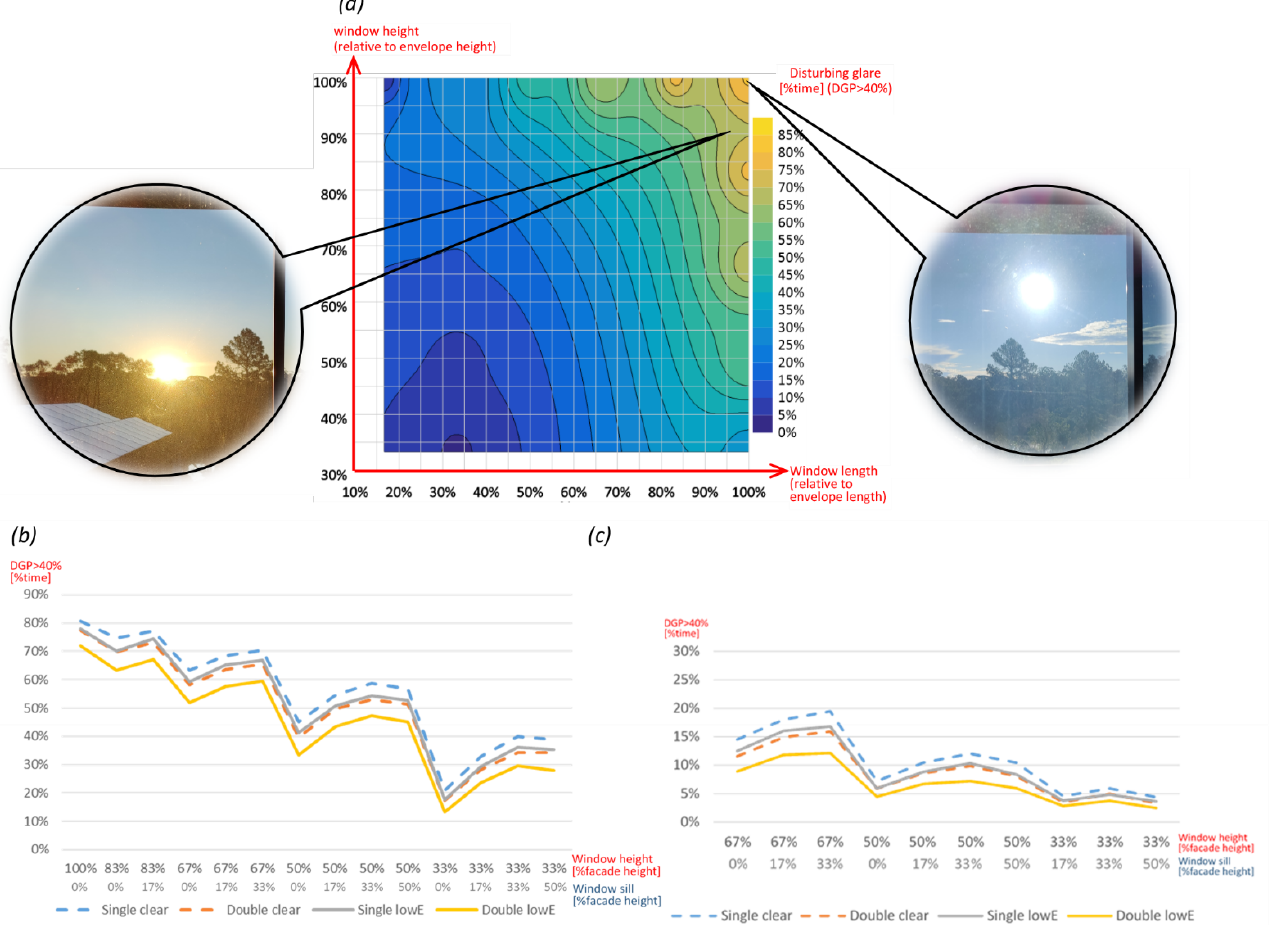
Figure 7. Yearly fraction of disturbing glare time for: ( a ) DGP study based on window height and width for clear single-pane window dimensions as well as some HQ images for the specific point of the graph during working time; ( b ) DGP change based on window width, sill level, and glazing for W w = L windows for different glazings; and ( c ) DGP change based on window width, sill level, and glazing for W w < 33% L for different